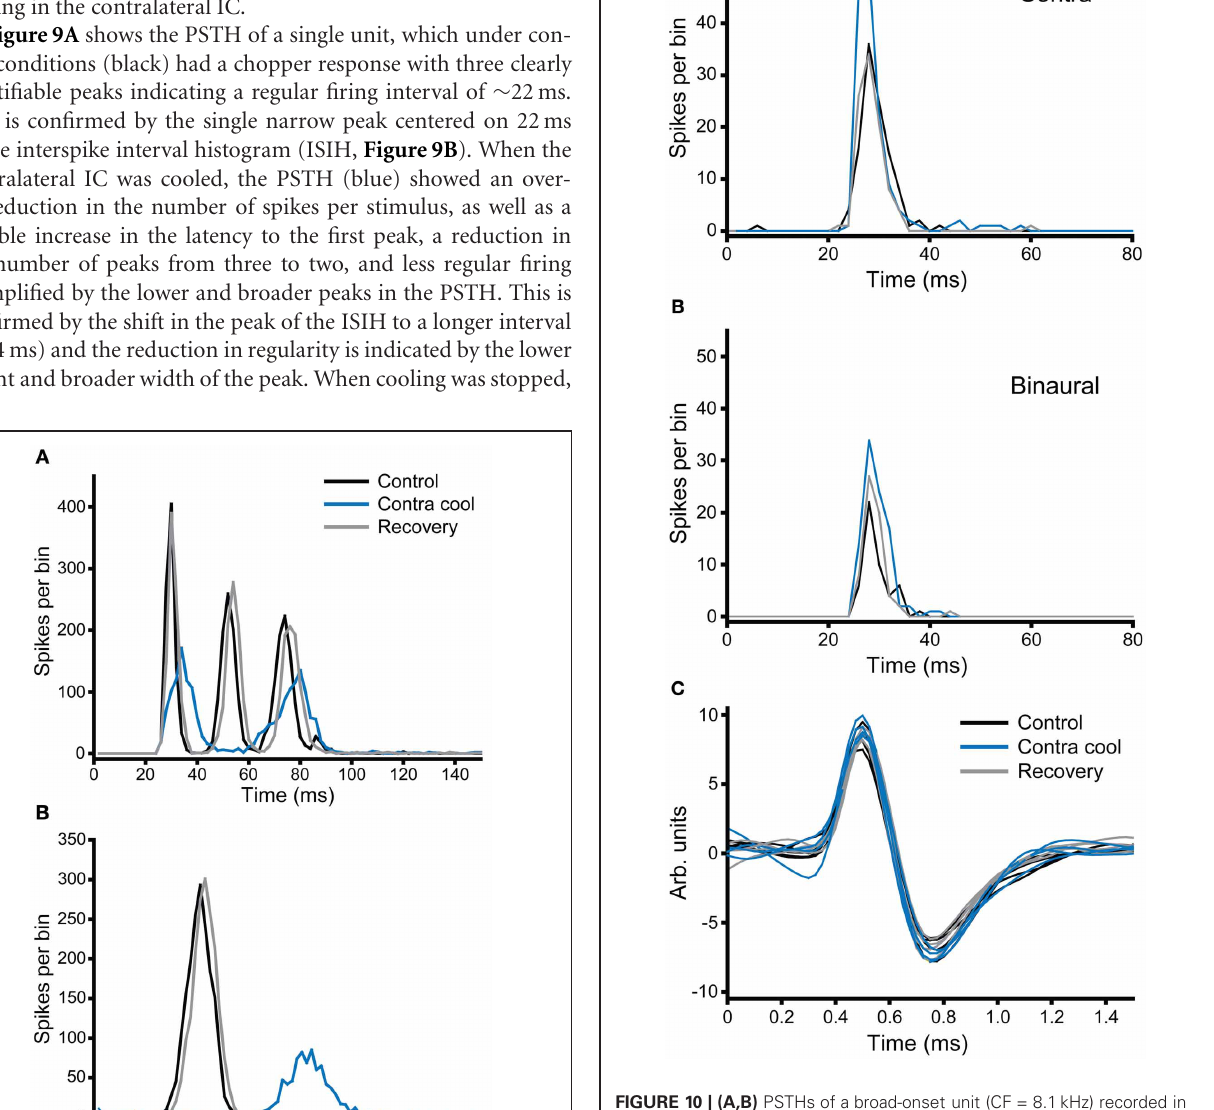
FIGURE 10 | (A,B) PSTHs of a broad-onset unit (CF = 8.1kHz) recorded in the IC contralateral to the cryoloop before, during and after cooling. The number of spikes elicited to stimulation of the contralateral ear (A) increased during cooling and returned to the control value on recovery. In response to binaural stimulation (B) the unit showed an EI characteristic, but firing similarly increased with cooling. (C) Five examples of action potentials recorded during each of the three stages of the paradigm; the morphology of the action potential did not change during cooling of the contralateral